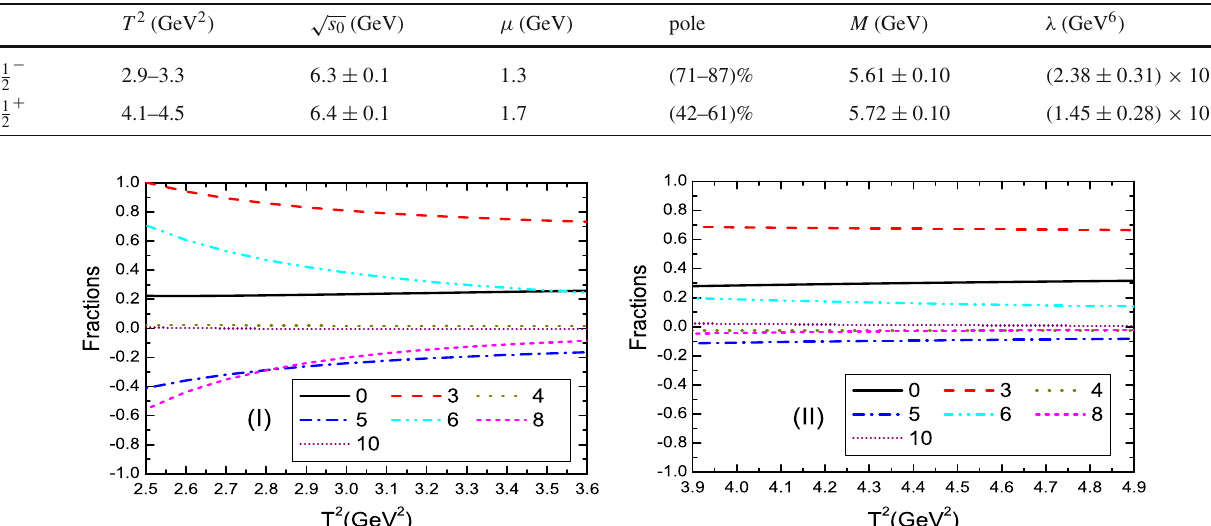
Table 1 The Borel parameters (Borel windows), continuum threshold parameters, optimal energy scales, pole contributions, masses and pole residues for the triply-charmed pentaquark states